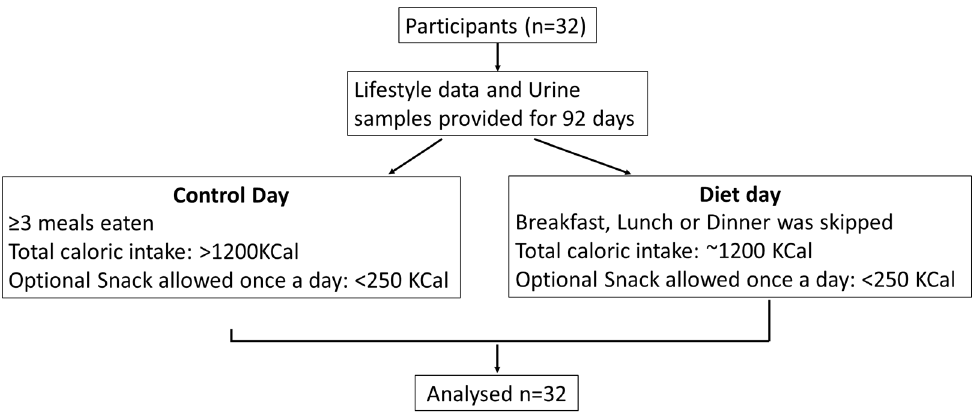
Figure 1. Study design.